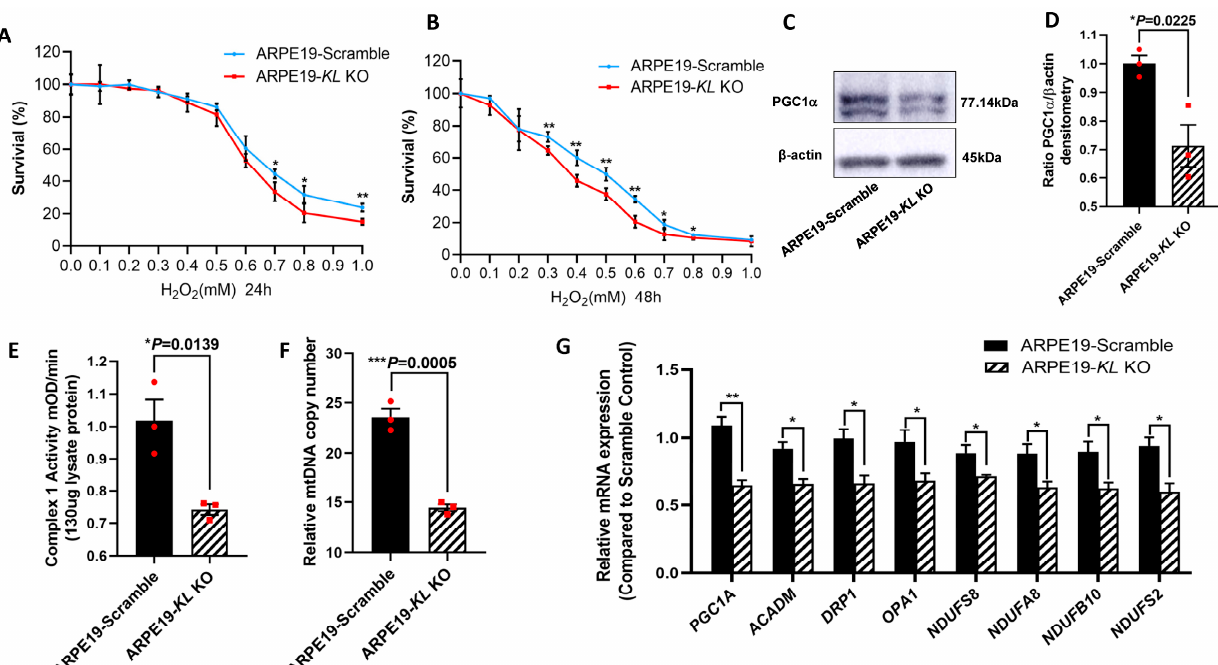
Figure 6. Inhibition of KL in human RPE reduces the cell viability and mitochondrial activity. ARPE19-CRISPR/Cas9- KL KO cells were treated with increasing concentrations of H 2 O 2 for 24 h ( A ) or 48 h ( B ), followed by cell viability analyses. Cell viability was significantly higher in the control as compared to that of the ARPE19- KL KO cells at high concentration of H 2 O 2 after 24 h of H 2 O 2 treatment. Longer exposure to oxidative stress (48 h, H 2 O 2 ) showed significant differences between the ARPE19- KL KO and control cells for 0.3–1 mM of H 2 O 2 . The mean ± SD and the p -values were calculated for statistical significance. Holm–Sidak t -test was performed using GraphPad Prism 8.3.0. * p ≤ 0.05, ** p ≤ 0.01. ( C , D ) PGC1 α protein levels were significantly lowered by inhibition of KL in ARPE19 cells for 4 weeks. ( D ) Densitometry analyses were performed by ImageJ software. ( E ) Mitochondrial complex1 activity was significantly reduced in the ARPE19- KL KO as compared to that in the scrambled control cells. ( F ) The mtDNA copy number was measured in the ARPE19- KL KO cells (n = 3) by qPCR, showing it was significantly reduced as compared to that of the control. ( G ) mRNA expression levels of mitochondrial activity-related genes, PGC-1 α , ACADM , DRP1 , OPA1 , NDUFS2 , NDUFS8 , NDUFA8, and NDUFB10 were significantly decreased after inhibiting the KL in ARPE19 cells for 3 weeks. The unpaired t -test was performed using GraphPad Prism 8.3.0. Graph represents mean ± SEM, n = 3, * p ≤ 0.05, ** p ≤ 0.01, *** p ≤